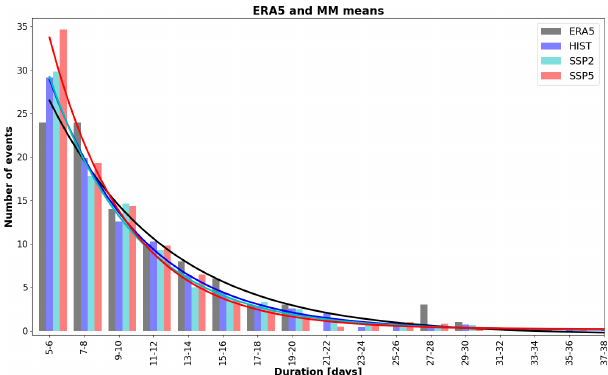
Figure 4. Occurrence of blocking events as a function of blocking duration for ERA5 and MM means during HIST, SSP2, and SSP5, considering (cid:49) Z500 HIST , (cid:49) Z500 SSP2 , and (cid:49) Z500 SSP5 . Exponen- tial fits are drawn for ERA5 and MM